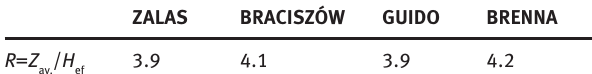
Table 3 : Average values of R